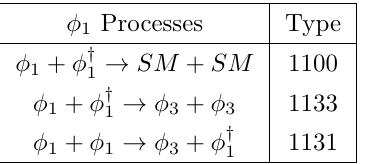
Table 2 . The 2 → 2 processes that are allowed in the Z 6 (13) model and that can modify the relic density of φ 1 (left) and φ 3 (right). Notice that semi-annihilation processes are not allowed in this model. Conjugate and inverse processes are not